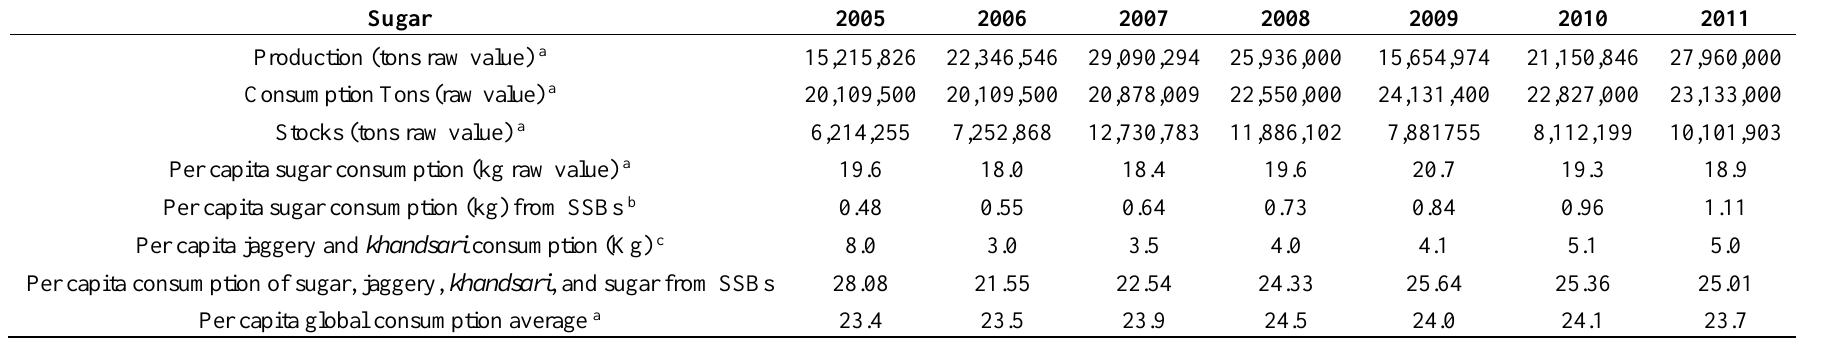
Table 3. Sugar production, consumption, and stocks in India, 2005–2011.